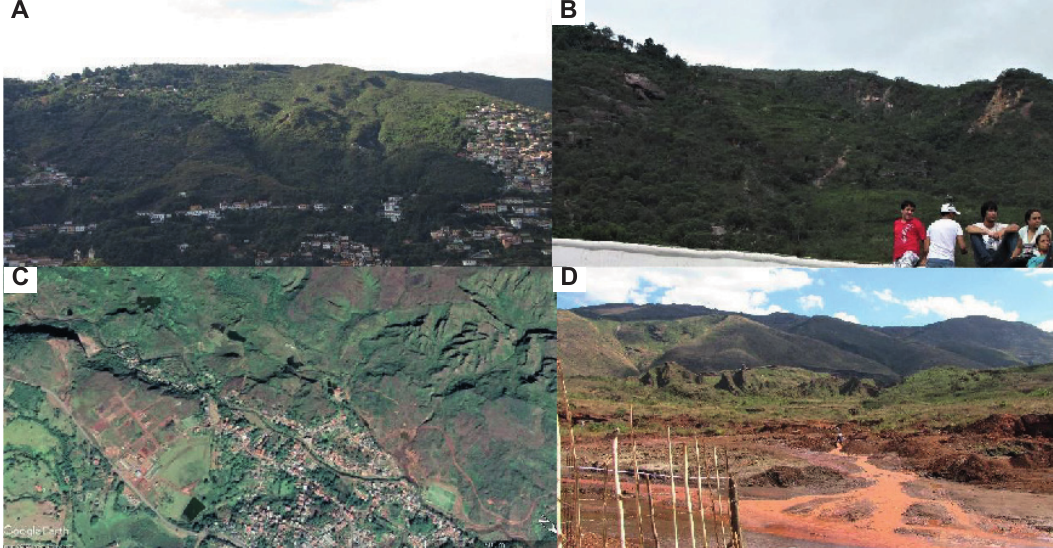
FIGURE 2 . Examples of Class 2 Geo-mining Heritage. A - image of the Serra de Ouro Preto showing areas of urban occupation interspersed with areas of dismantling caused by gold mining throughout the 18th century. Note the areas of great roughness that result from dismantling by mining in the neighborhoods of Alto da Cruz and Padre Faria; in the background the Morro da Queimada. B - details of part of the Ouro Preto mountain. C - rough relief, caused by intensive gold mining, west of Antônio Pereira district, Ouro Preto (Google Earth 2020). D - in the middle plane, relief with pinnacles, resulting from the intense mining of